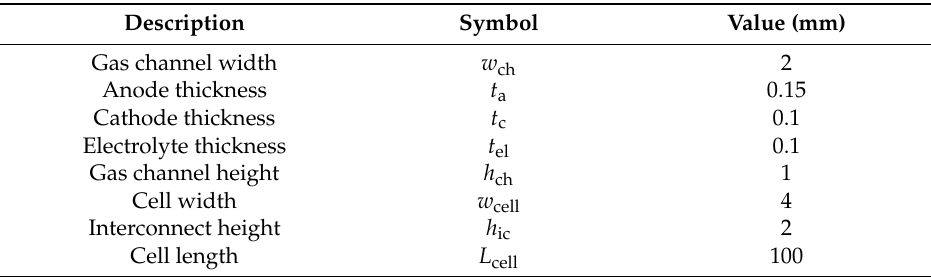
Figure 1. ( a ) Schematic of SOFC geometry and dimensions; ( b ) computational domain and boundary conditions of a single channel. Table 1. Dimensions of solid oxide fuel cell